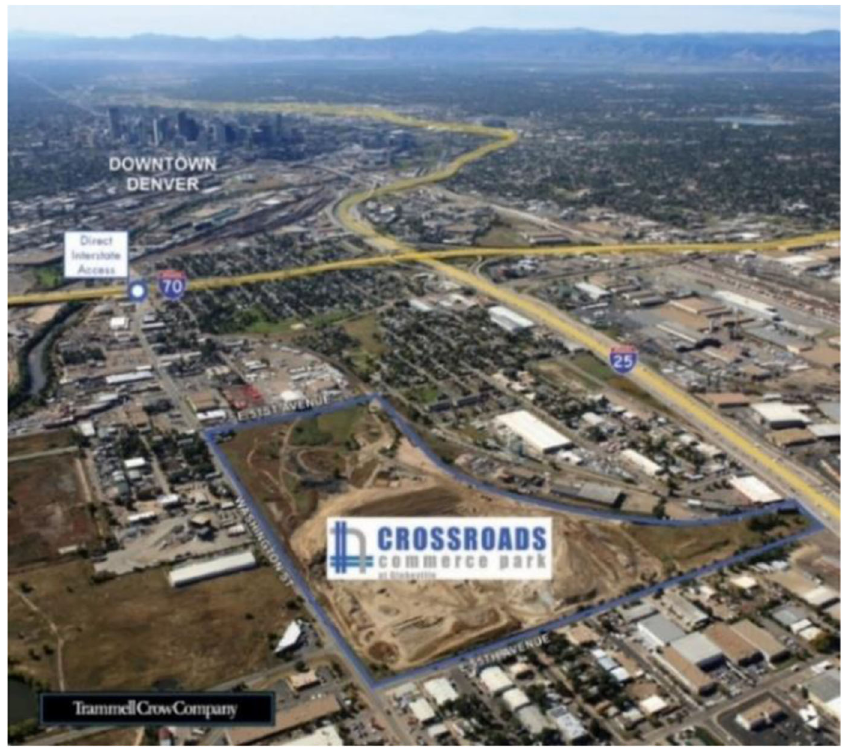
Fig. 2 Globeville, the industrial community Source: Globeville, the Industrial